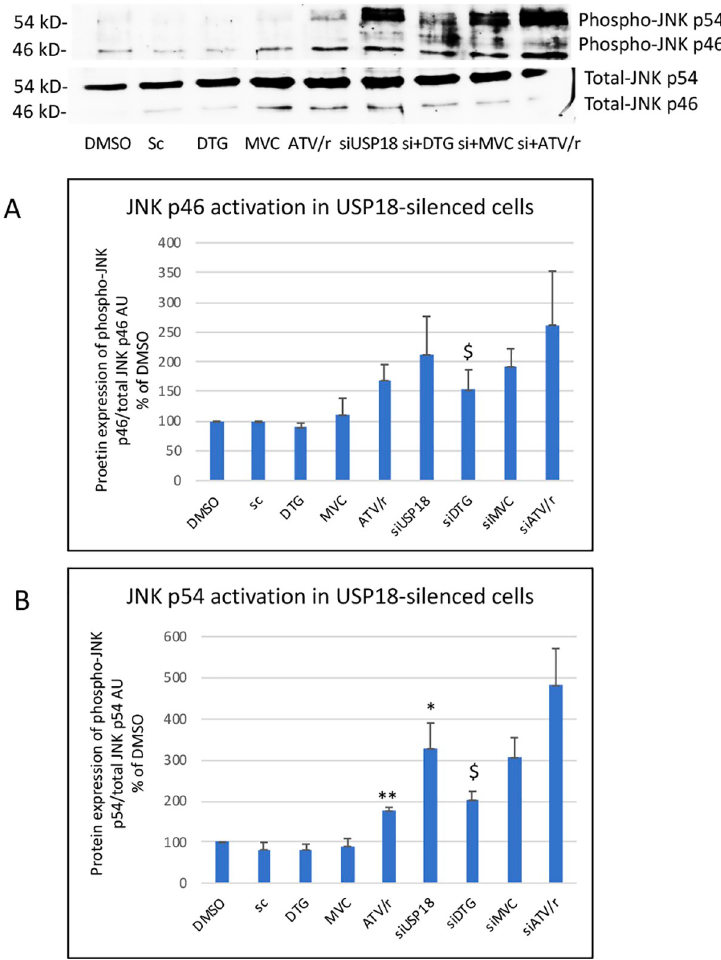
Fig 12. Effect of USP18 silencing on the ability of DTG, MVC and ATV/r to modulate basal activity of JNK1(p46) and 2(p54) involved in insulin resistance. A representative Western blot of phospho-JNK p46 and p54 and of total JNK p46 and p54 is shown. Both JNK activations were evaluated by the ratio of the phospho- to the total form for each enzyme. The histograms represent the mean+/-SEM value as compared to the DMSO control set at 100% of 3 independent experiments. Si-DMSO: control silenced for USP18, Si-DTG: DTG-treated cells silenced for USP18, Si- MVC: MVC-treated cells silenced for USP18, Si-ATV/r: ATV/r-treated cells silenced for USP18. The comparisons used Welch’s correction of Student T-test. �� p < 0.01 versus control (DMSO) $ p < 0.05 versus Si-USP18 (Si-DMSO).